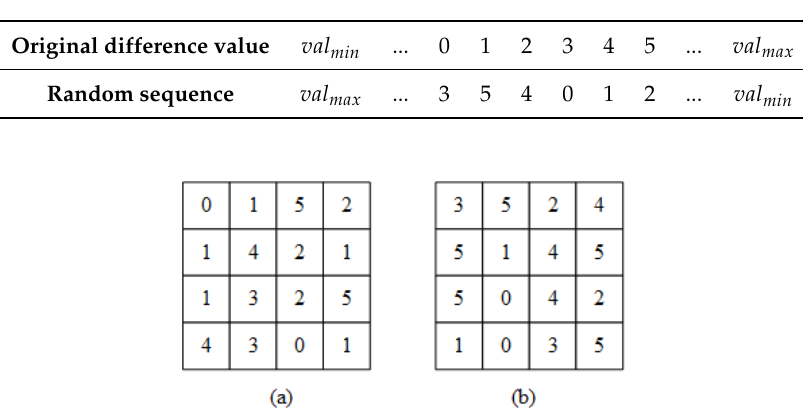
Figure 3. The sample of value replacement, ( a ) an example of the original difference matrix, ( b ) difference matrix after value